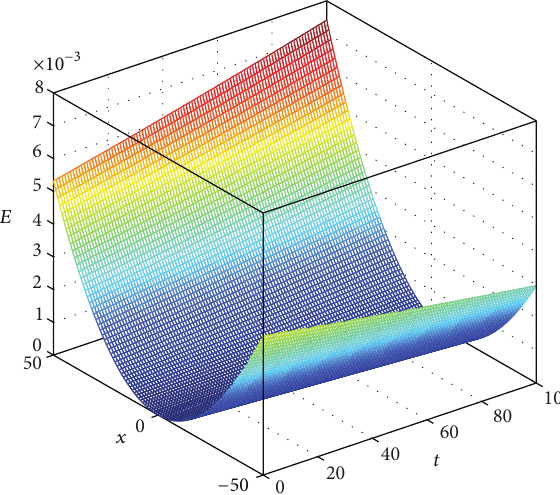
Figure 9: Absolute error of generalized Burgers-Fisher-type equa- tion, (24), with 𝛿 = 2 , 𝛾 = 0.001 , and ] = 0.25 .